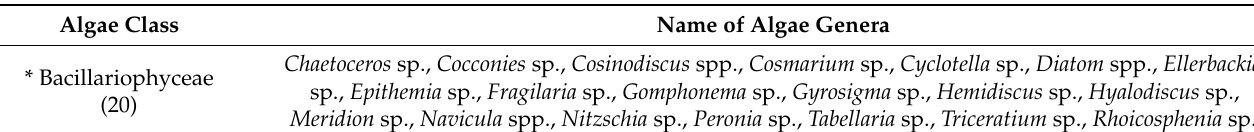
Table 1. List of Algae genera recorded from the homestead ponds of coastal